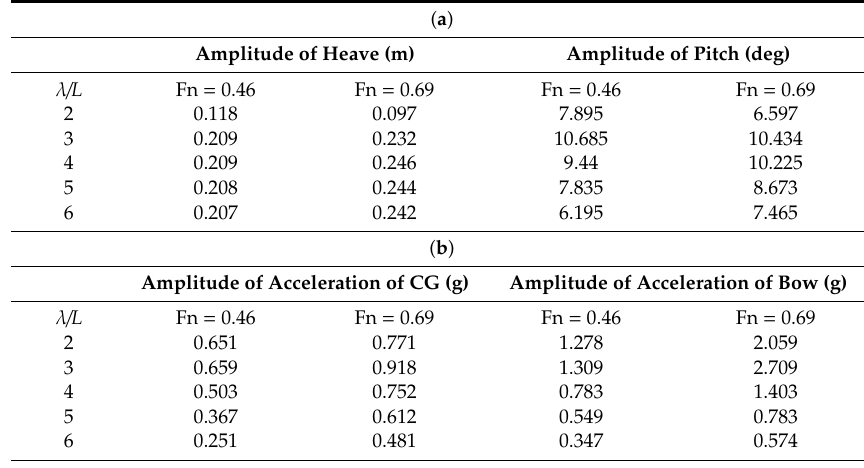
Table 14. RAOs of the improved vessel at di ff erent speeds and with di ff erent wave lengths: ( a ) Heave and pitch; ( b )